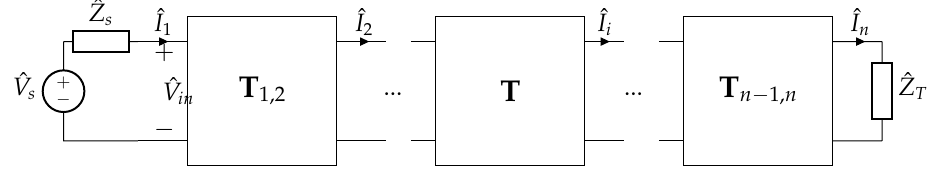
Figure 3. Equivalent representation of a resonator array by a cascade connection of two-port networks.